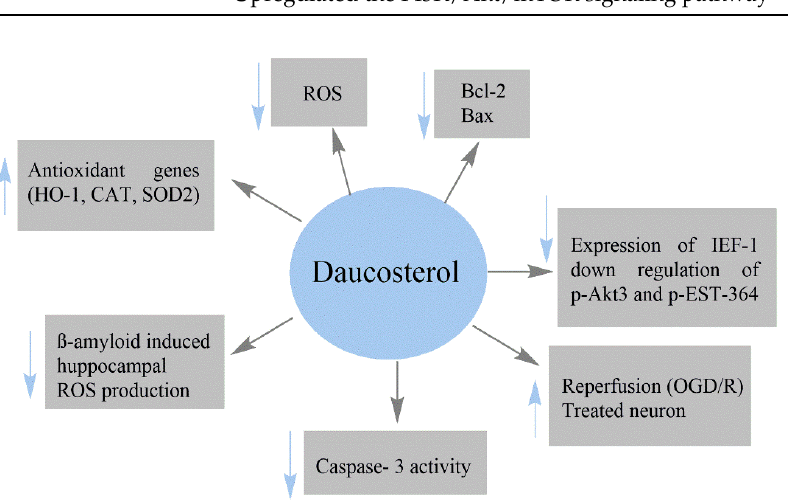
Figure 3. Neuroprotective effects of Daucosterol. The arrow indicates increasing or decreasing.